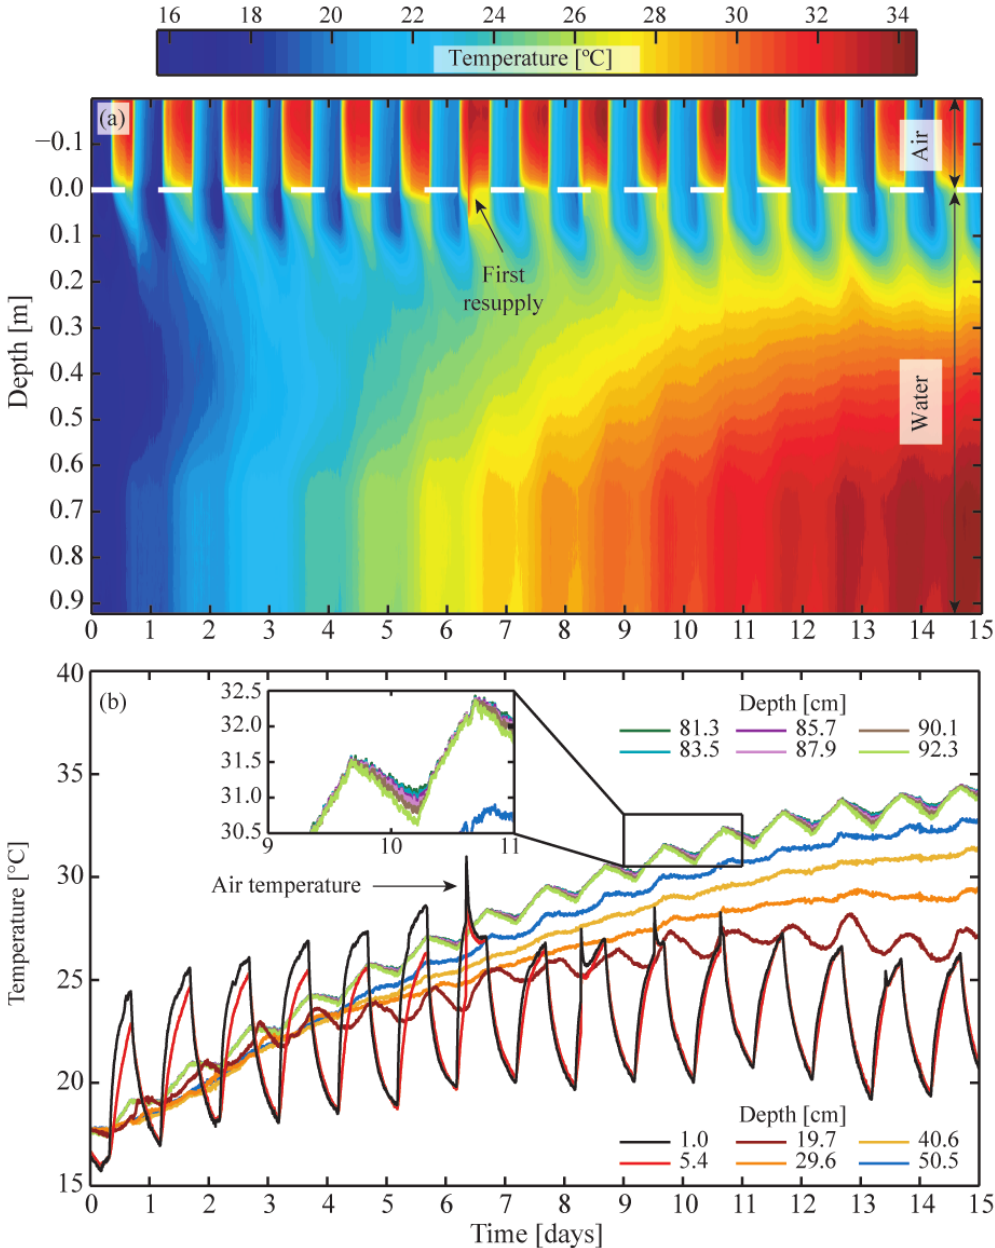
Fig. 4. (a) Thermal evolution of the water column and the air above it collected with the vertical high-resolution DTS system. (b) Time series of temperature at specific depths inside the solar pond. These measurements were obtained using the manufacturer-internal calibration